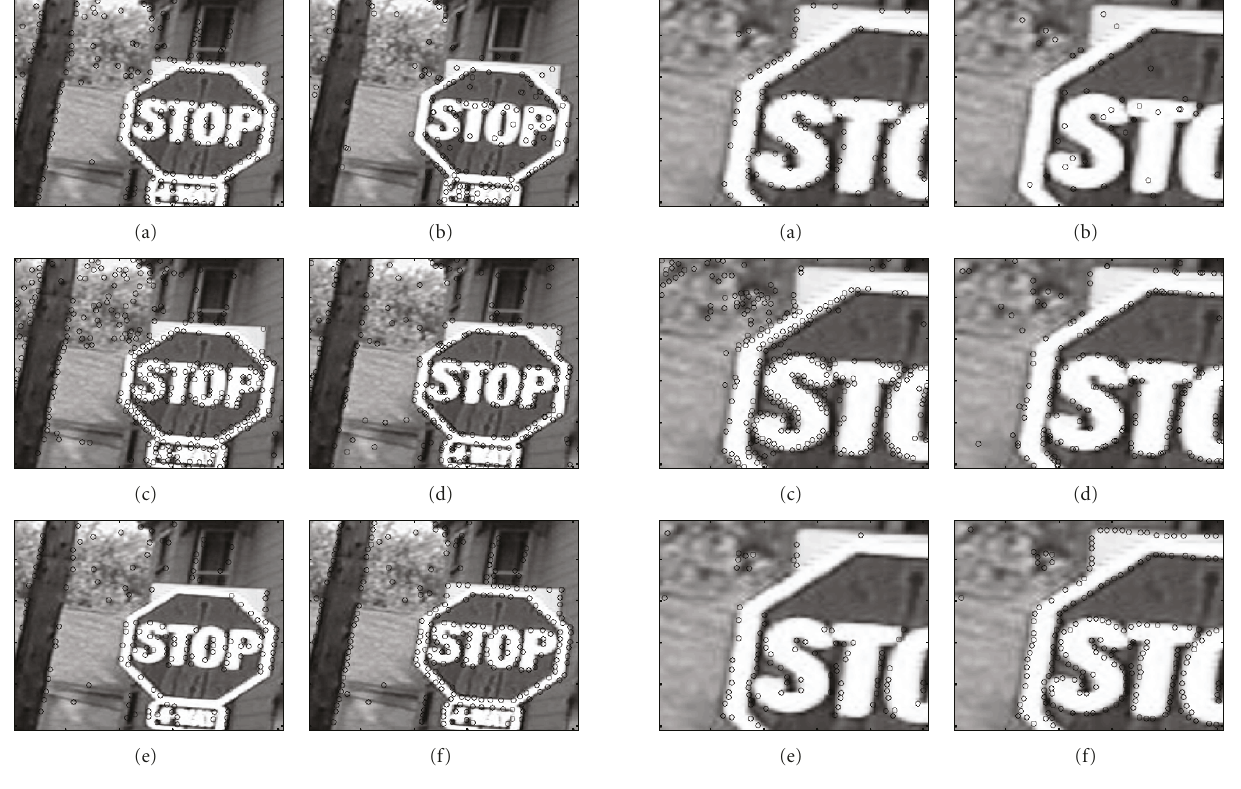
Figure 9: Feature points detected in 1.5 times scaled image by (a) Harris method (b) Lowe’s method, (c) Tomasi’s method, (d) Loupias’s technique, (e) Yeh’s algorithm, and (f) proposed technique.